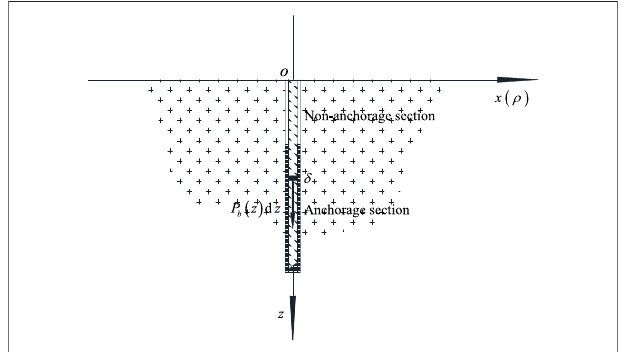
FIGURE5| Schematicdiagramof P b ( z ) actingonthesurroundingrock.